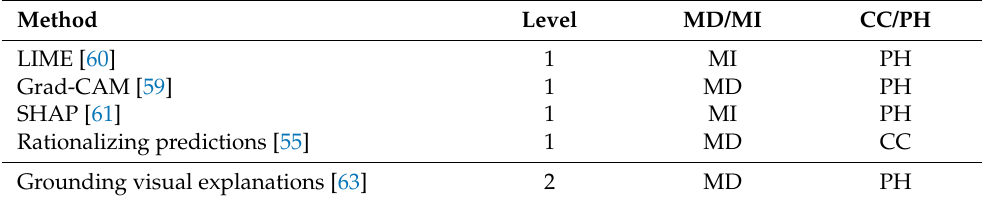
Table 2. Classification of recent explanation techniques based on levels of explanation. MD stands for model dependent while MI means model independent. CC corresponds to concurrently constructed explanations and PH refers to post-hoc